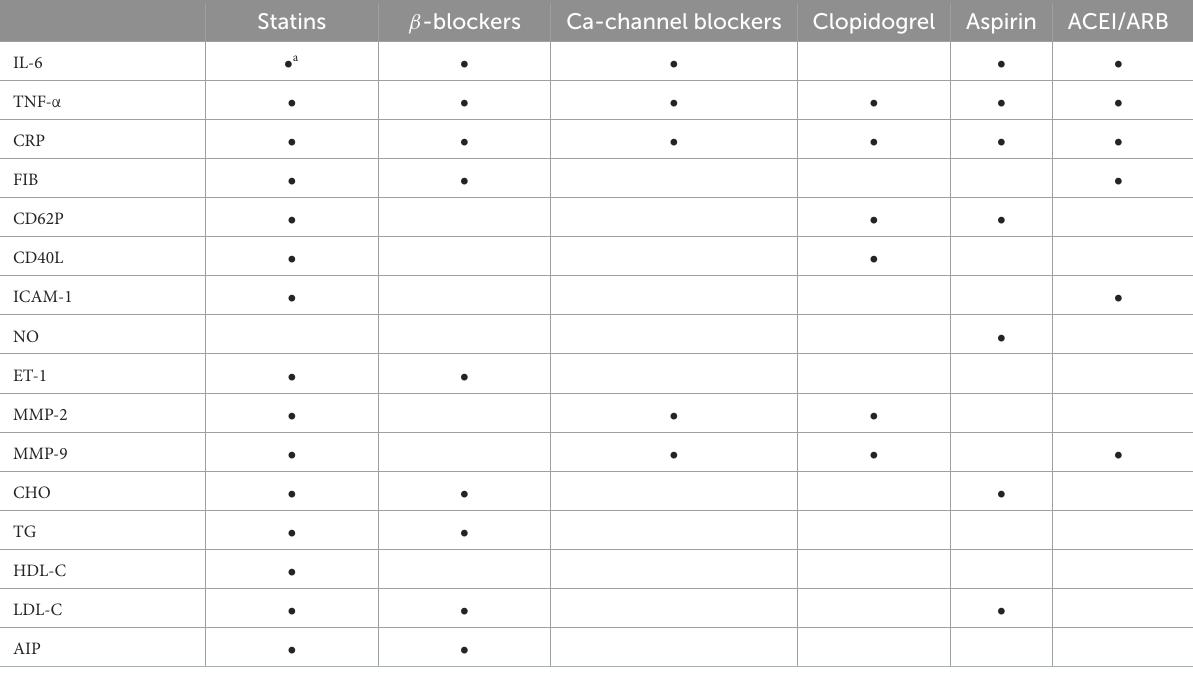
TABLE 3 Effects of 6 kinds of drug on cardiovascular